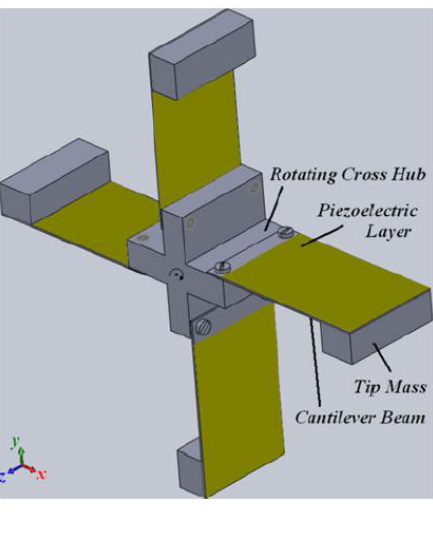
Figure 28. Schematic view of rotatory motion harvester ( © 2013 IEEE. Reprinted with permission from [120]).